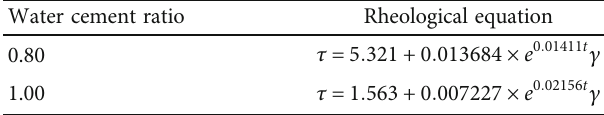
Table 4: Rheological equation of cement